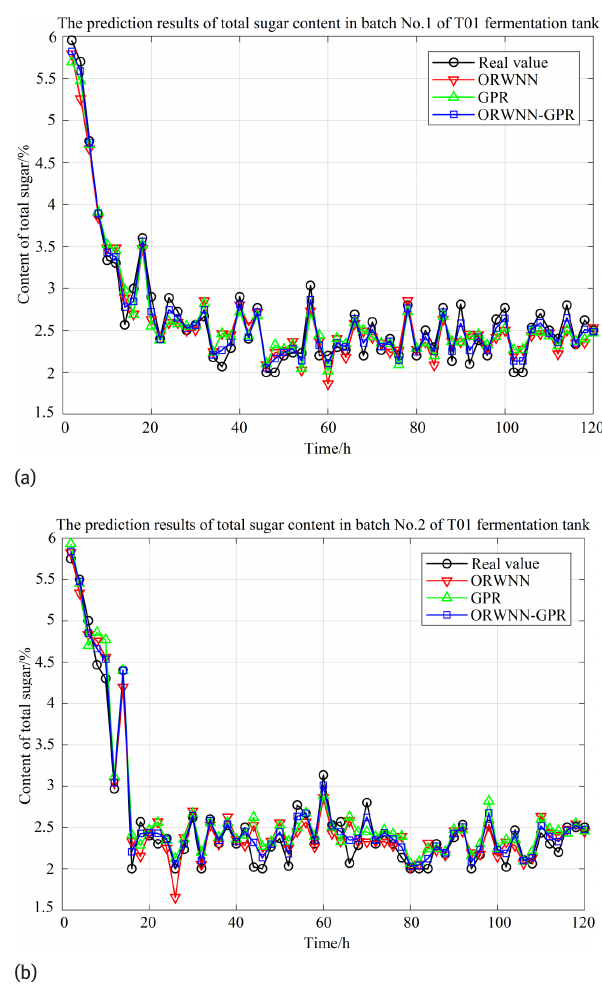
Figure 3: Comparison of total sugar content prediction results in two batches of T01 fermentation tank